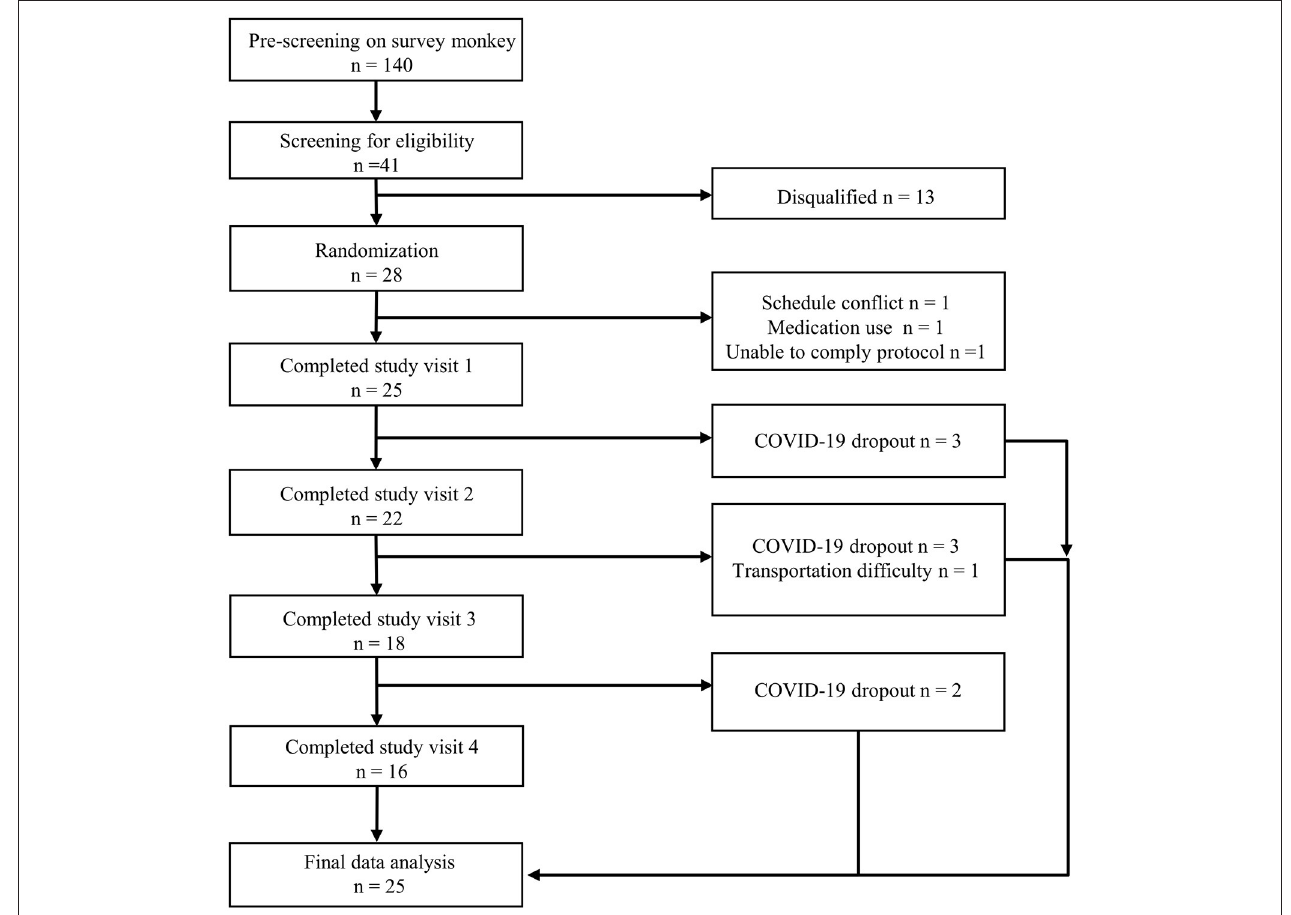
FIGURE 2 | Consolidated Standards of Reporting Trials (CONSORT) flow diagram of the study.